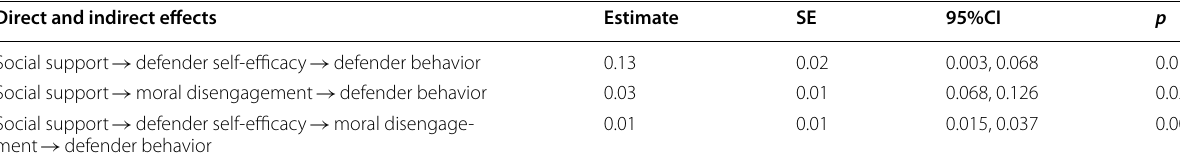
Table 3 Summary of the direct and indirect effects Direct and indirect effects